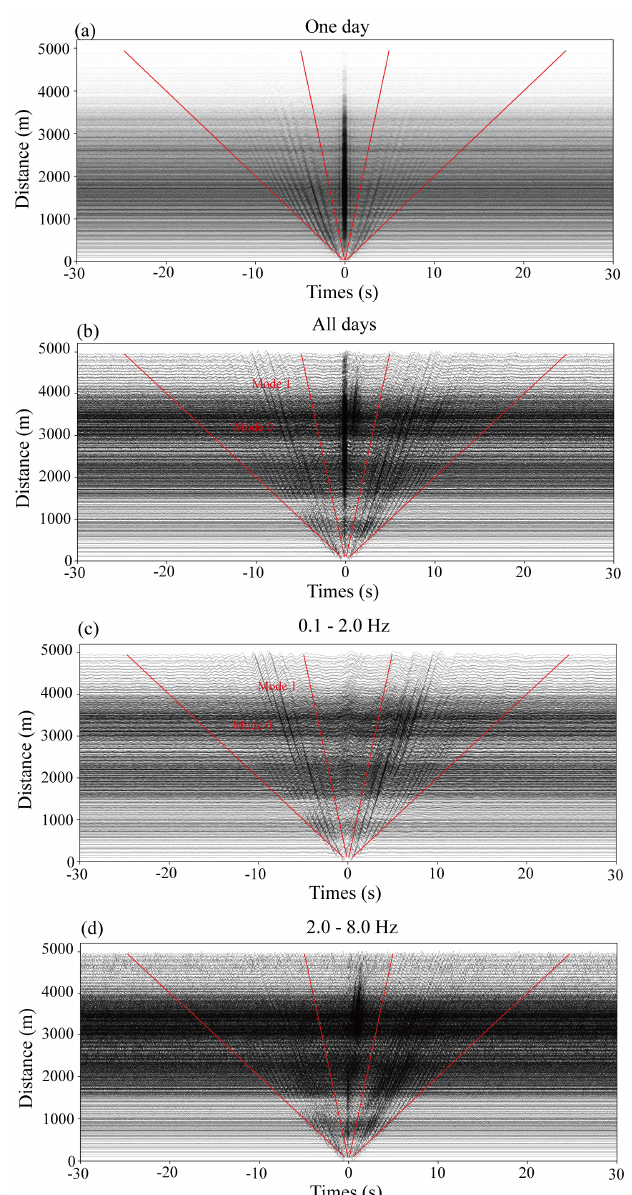
Figure 2. Noise cross-correlation functions (NCFs). The two solid red lines represent the arrival times of 200 m/s and 1000 m/s. The positions of the fundamental mode (mode 0) and the first high mode (mode 1) are marked. ( a ) All NCFs of one day; ( b ) the NCFs between station 20361036 (as virtual source) and other receiver stacking results for a period of almost one month; ( c ) the result of the band-pass filtering of ( b ) 0.1–2.0 Hz; and ( d ) the result of band-pass filtering of ( b ) 2.0–8.0